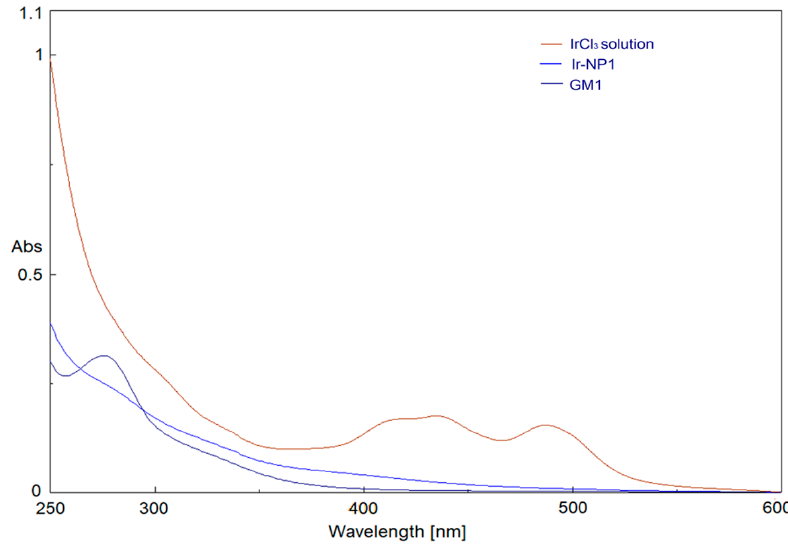
Figure 1. UV-Vis absorption spectra of IrCl 3 , GM1 precursors, and Ir-NP1. Table 2. TEM and DLS features of synthesized